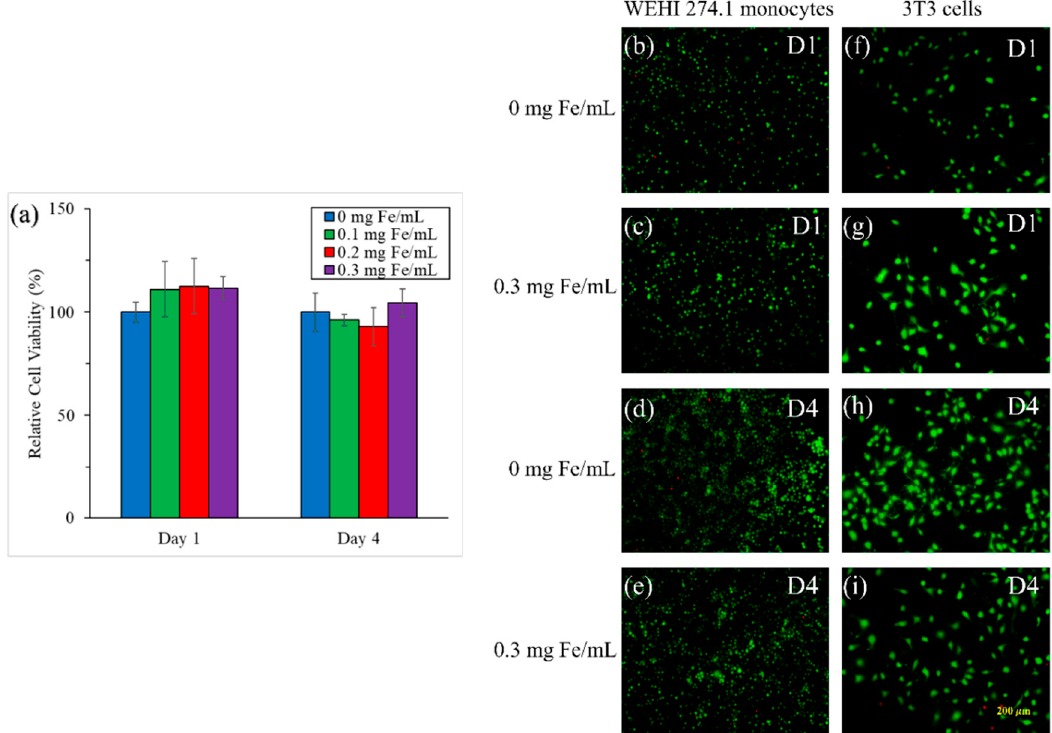
Figure 5. ( a ) MTT assay of 3T3 cells with different concentration of MCP-1-motif MNPs; ( b – i ) Live/Dead staining of WEHI 274.1 monocytes ( b – e ), and 3T3 cells ( f – i ) in 0 and 0.3 mg Fe/mL at day 1 (D1) ( b , c , f , g ) and day 4 (D4) ( d , e , h , i ) ( n = 4).